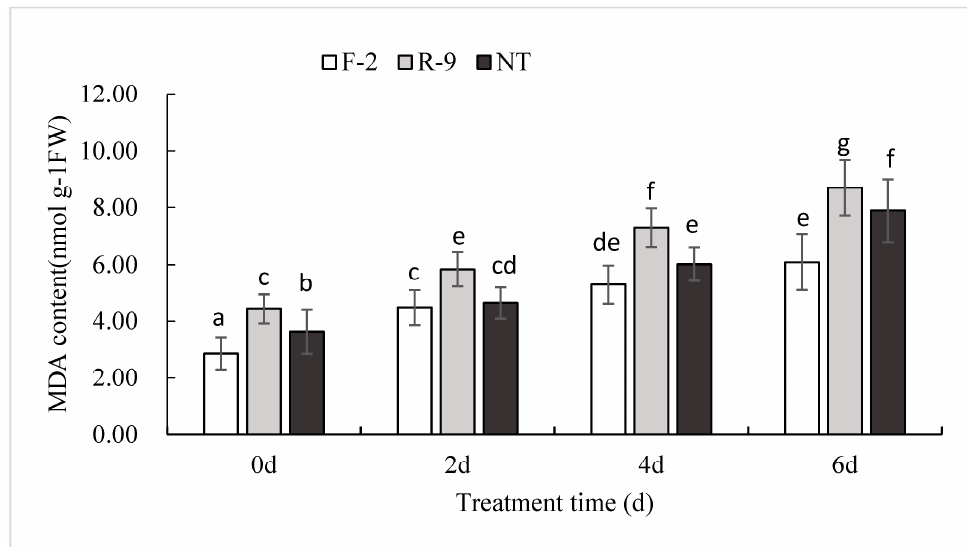
Figure 8. Malondialdehyde content of ScD27.2 F-2 and ScD27.2R-9 transgenic lines and NT non- transgenic controls. Duncan’s new multiple range methods were used to analyze significant differ- ences in gene expression at different time points after 6 days of stress treatment in 20% PEG-8000 MS medium. Different lowercase letters indicate significant differences at the 0.05 level. The error line represents the standard error ( n = 9).